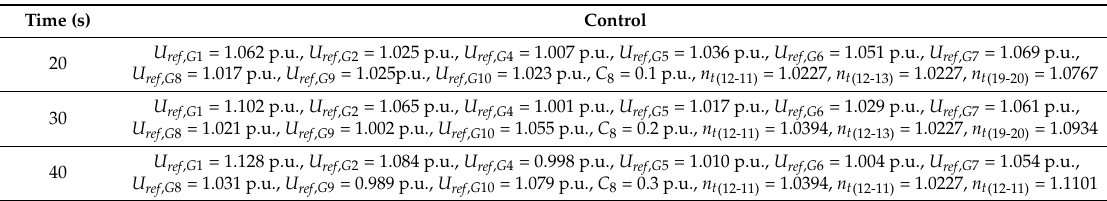
Figure 12. Voltage evolution using AH-MPC in case B. Table 3. Control actions in case